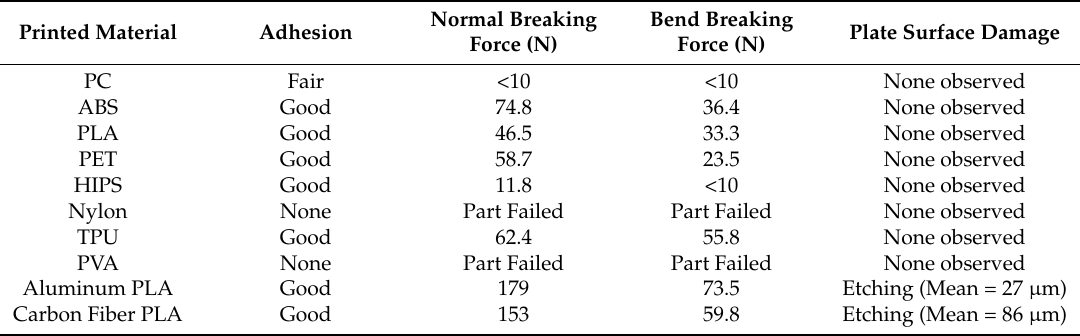
Table 4. Printing test results for untreated PC build plate.